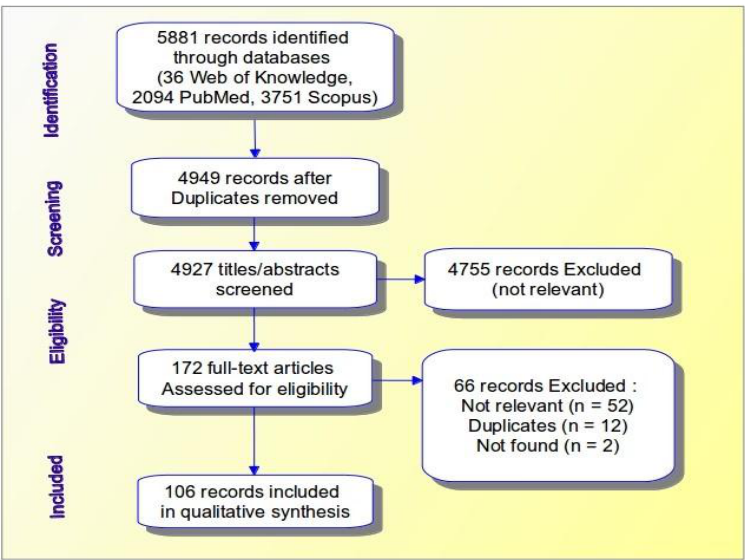
Figure 5. Flow of information through the different phases of the review.